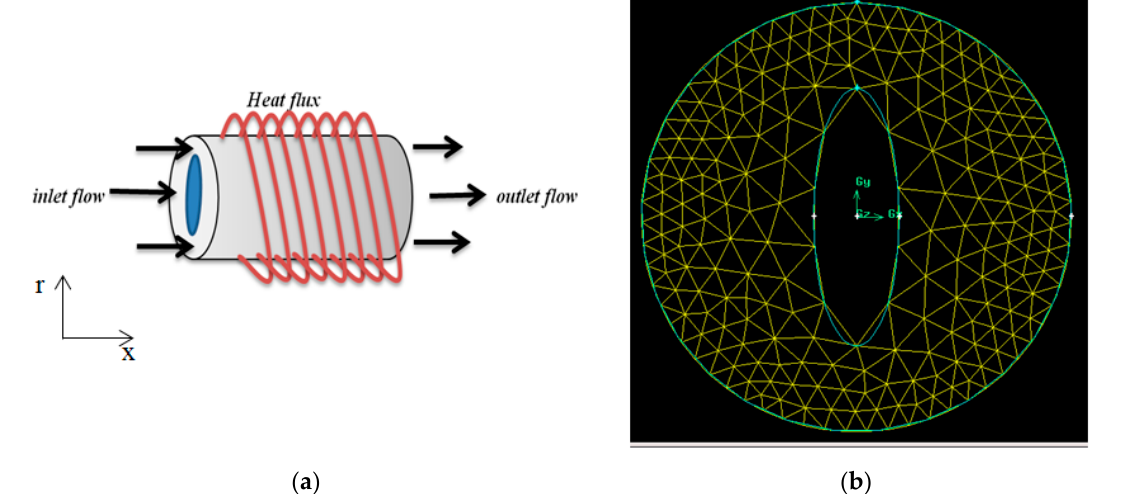
Figure 1. Geometrical problem. ( a ) Schematic of problem undertaken; ( b ) mesh generated by GAMBIT.